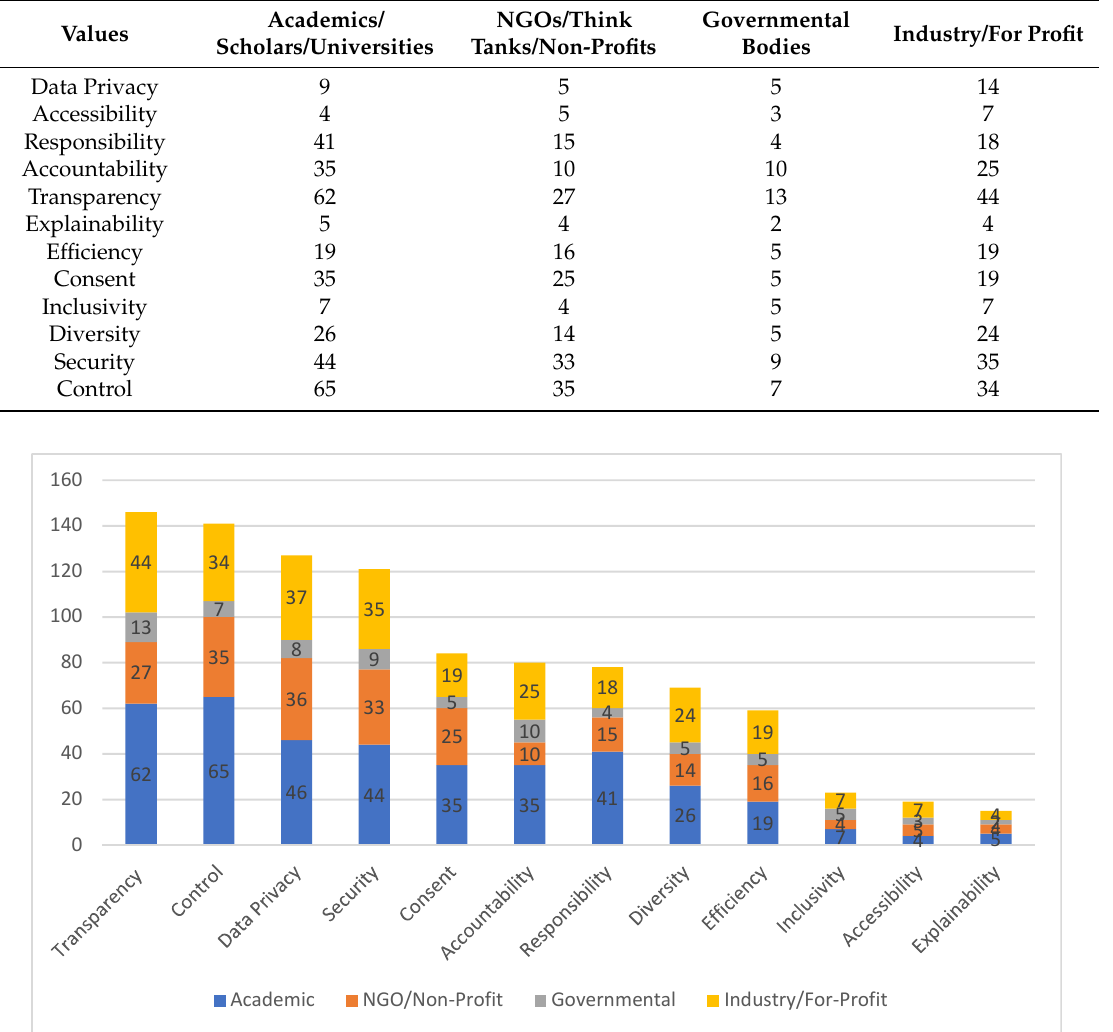
Figure 3. Rank-Order Distribution of Values. Numerical values represent individual report.